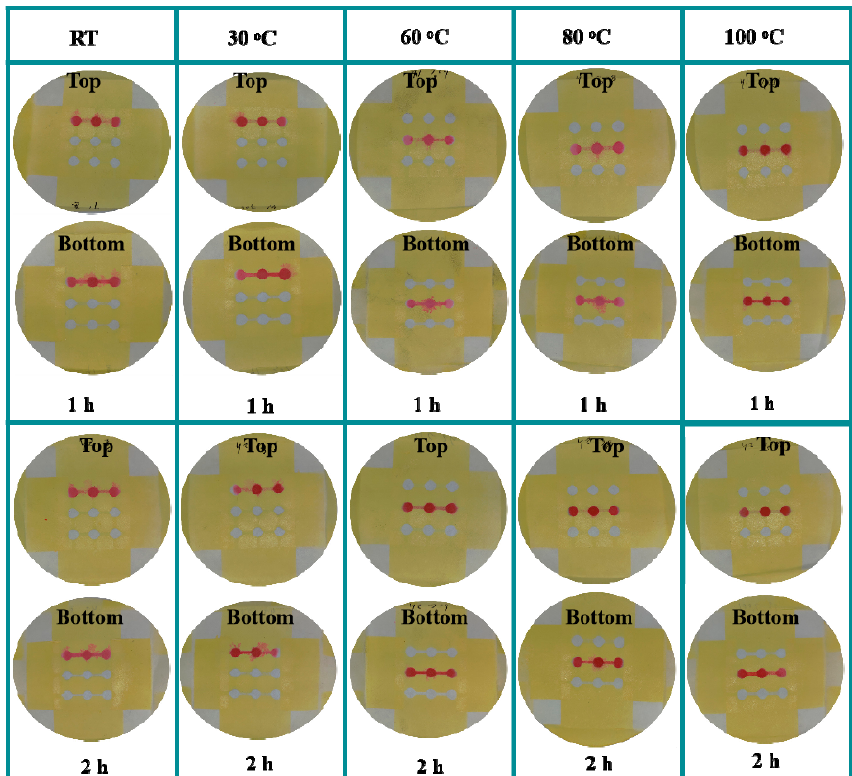
Figure 3. Optimization of the drying conditions for the fabrication of 3D sl- μ PADs.